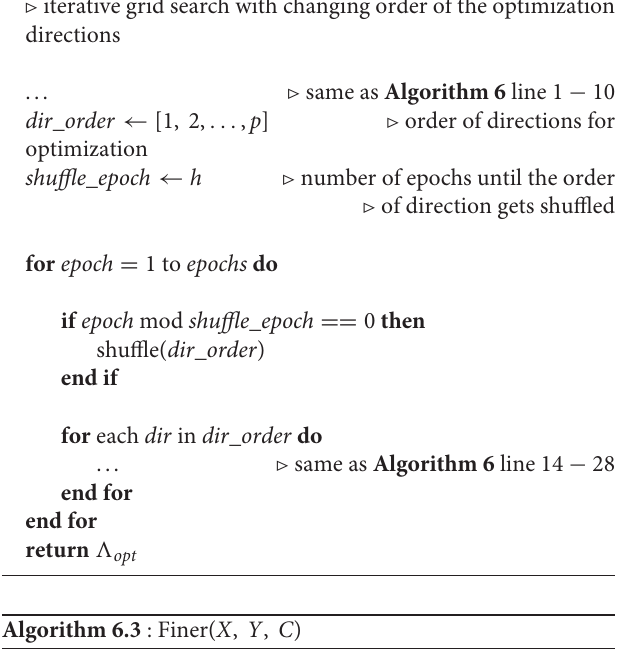
Algorithm 6.1 : Shift( X , Y , C ) Algorithm 6.2 : Shuffle( X , Y , C )